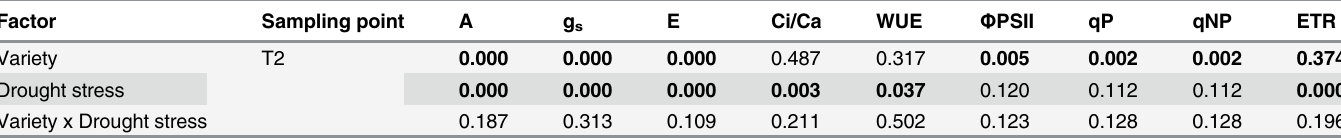
Table 3. Two-Way ANOVA on selected photosynthesis (A = net photosynthesis; g s = stomatal conductance to water vapour; E = leaf transpiration; Ci/Ca = ratio between stomatal and ambient CO 2 concentration; WUE = Water Use Ef fi ciency), and fl uorescence parameters